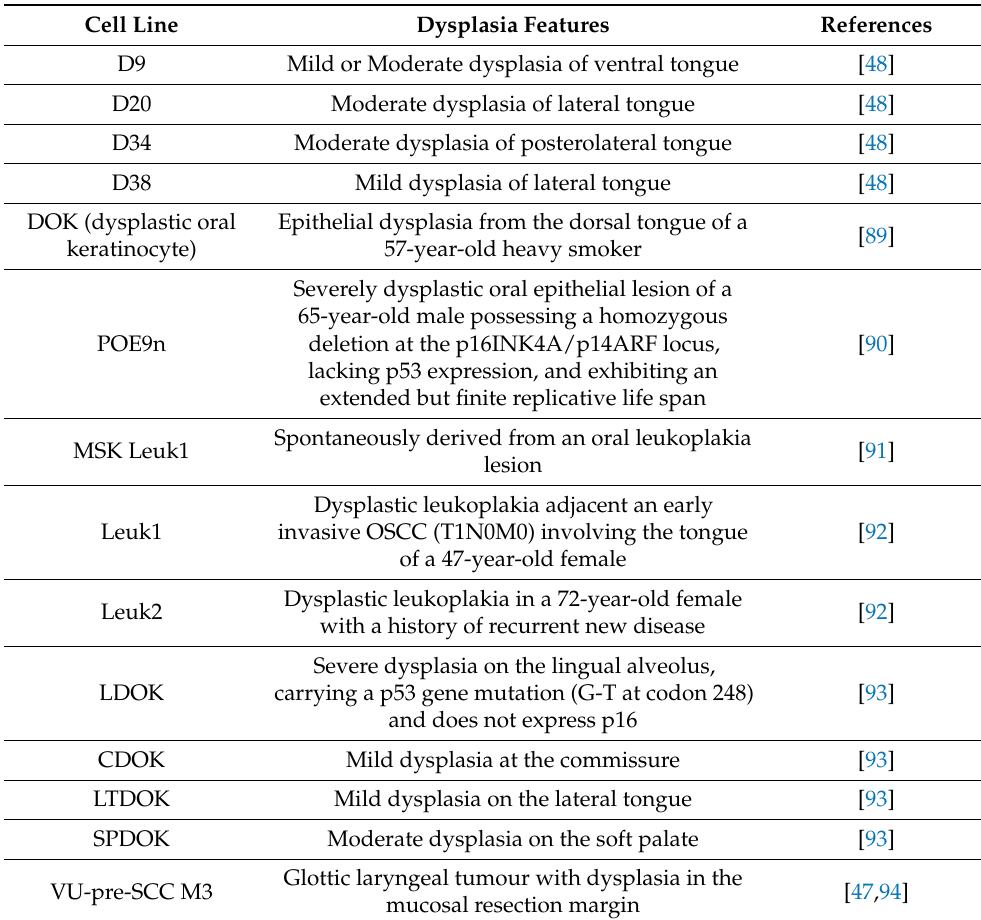
Table 2. Available cell lines to study oral premalignant disorders. (PMID: PubMed identification Member; ISSN: International Standard Serial